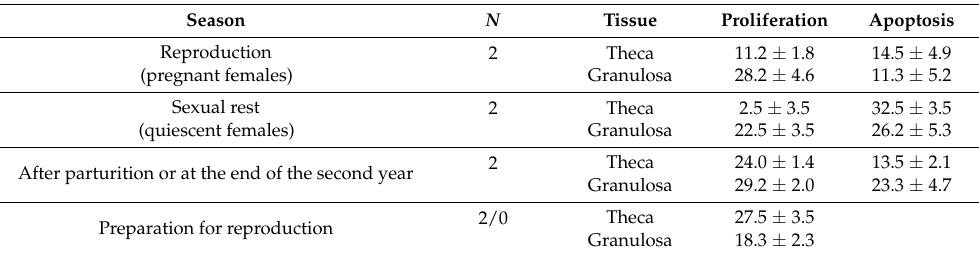
Table 2. Proliferative indexes (Ki67) and percentages of apoptotic cells (TUNEL/Apostain) in growing follicles in T. compressicauda during the year. N : number of